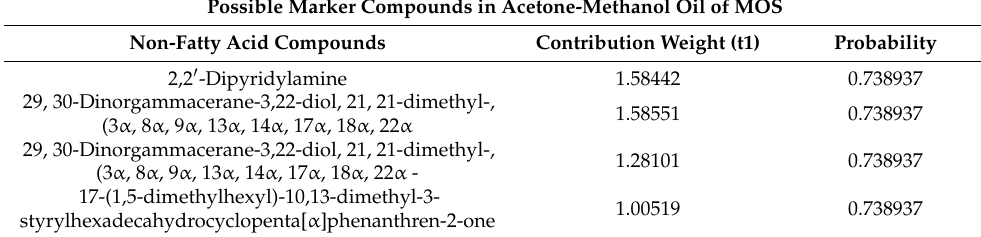
Table 5. The positively correlated compounds from which the marker compounds in the acetone- methanol extracts were